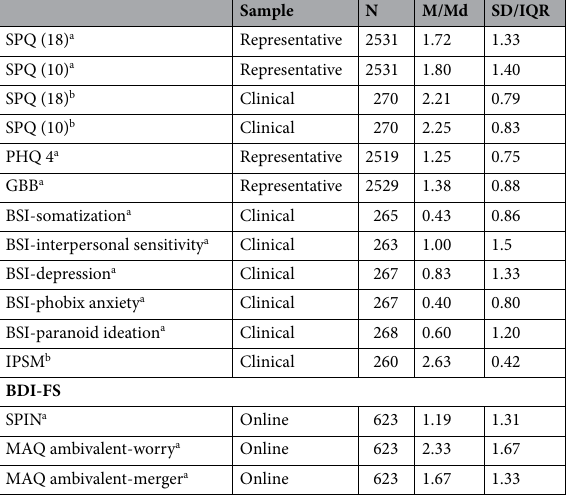
Table 1. Means (or medians) and standard deviations (or interquartile ranges) of measured constructs. a Normality can not be assumed, median and interquartile range are given. b Normality can be assumed, mean and standard deviation are